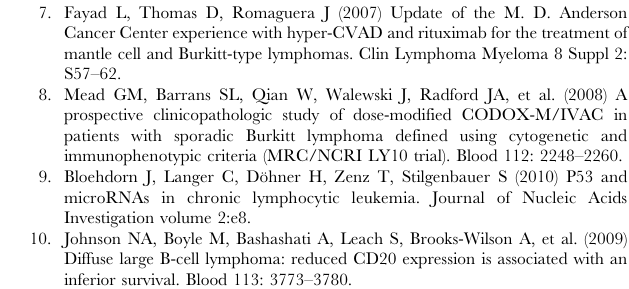
Figure S1 Characteristics of BNPs used in the experi- ments. Figure S2 Characterization of Burkitt model in SCID mice. Labeled BJAB (2 6 10 6 cells) were injected i.p. in SCID mice and specific staining of labeled-cells in tissues collected from untreated animals at day 7 was documented. Serial stacks were z- projected using average algorithm. The tissue auto-fluorescence to laser 488 nm is visible in green fluorescence. Objective Plan Apo 20X was used to achieve a low magnification capable of better describing the tissue environment. Original magnification 200 6 . Figure S3 Characterization of Burkitt model in SCID mice. Liver is infiltrated by neoplastic cells, which show a cohesive and diffuse growth pattern (A) and the same immuno- phenotypic profile observed in primary masses: anti-CD20 (B) and anti-Bcl-6 (C) (immunostainings, strept-ABC method). D) Foci of neoplastic lymphoid cells can be detected in the bone marrow and highlighted by anti-human-CD45 immunostaining (inset). Original magnification 200 6 . Figure S4 Effect of BNP2 in tumor mass of lymphoma- bearing mice. SCID mice received 2 6 10 6 BJAB cells i.p. and BNP1 or BNP2 (80 m L for 4 times) were injected i.p. from day 4. Tumor mass were collected at necroscopy and analyzed by H&E to detect necrotic/apoptotic